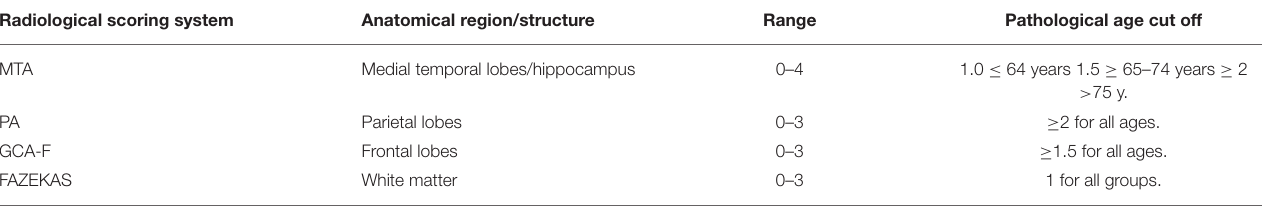
TABLE 4 | Radiological scoring systems, range, region and age cut off. Radiological scoring